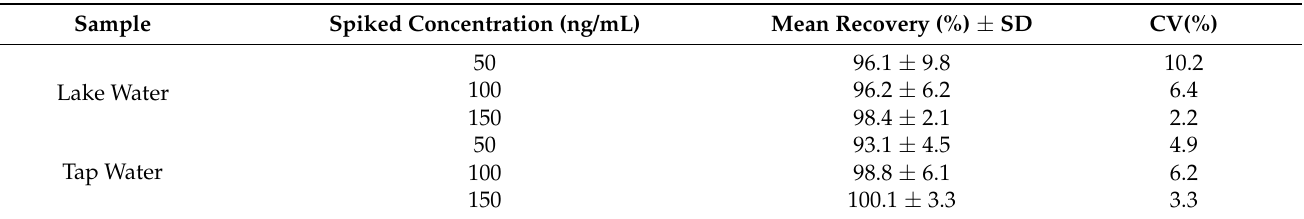
Table 2. Mean Recoveries and Coefficients of Variation for the SQX in Water Using Optimized Fluorescence ( n =